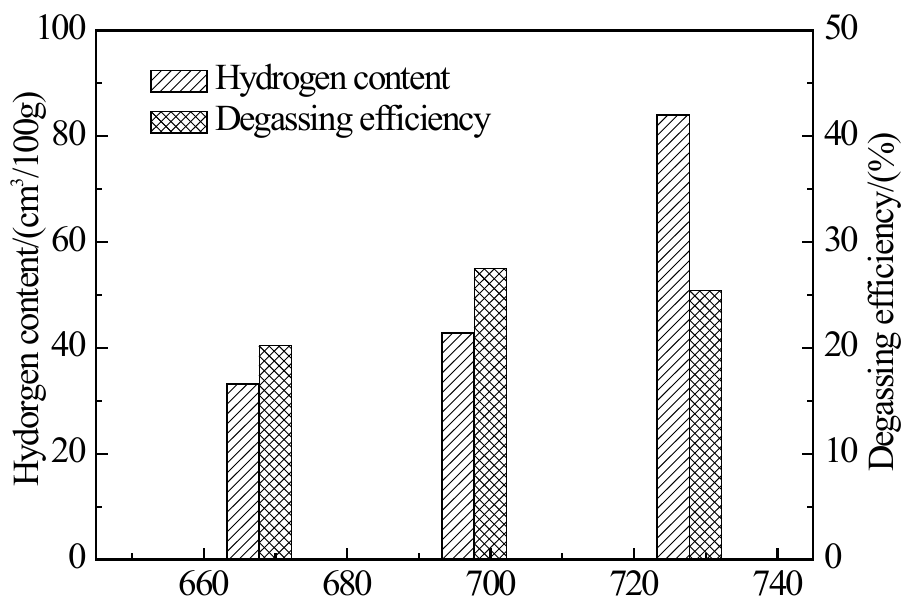
Figure 7. The effect of the ultrasonic treating temperature on the hydrogen content and degassing efficiency of Mg-3.03Ca alloy.